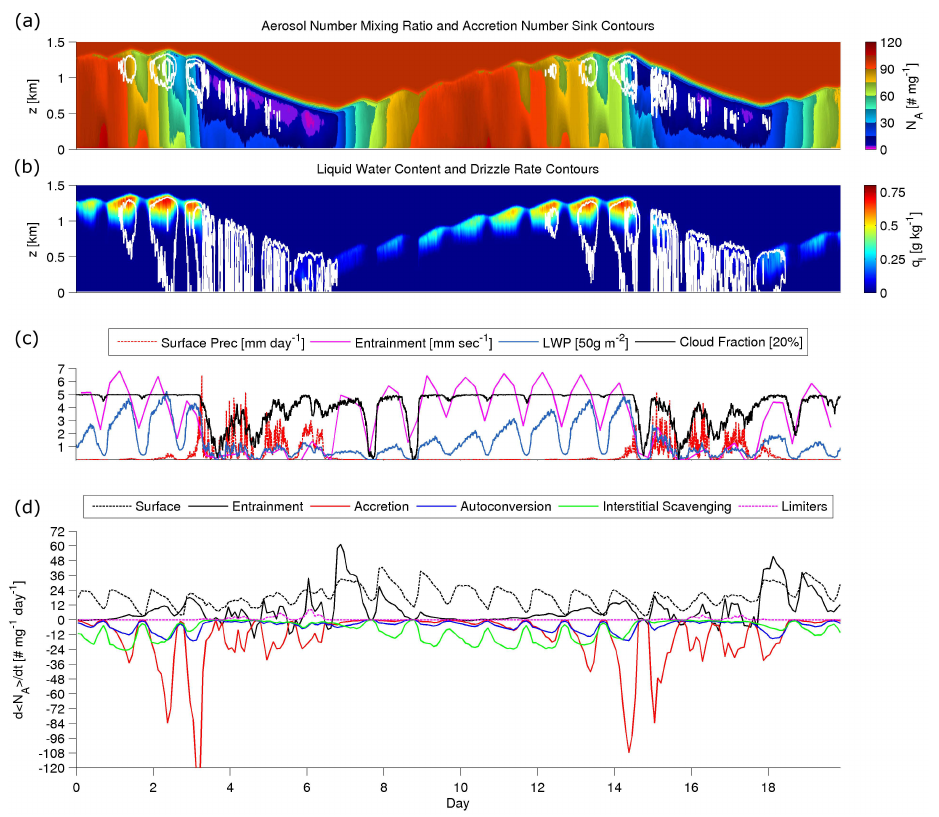
Fig. 8. Time-height plots and time series for run W5/NA100/DC. Panels as in Fig.